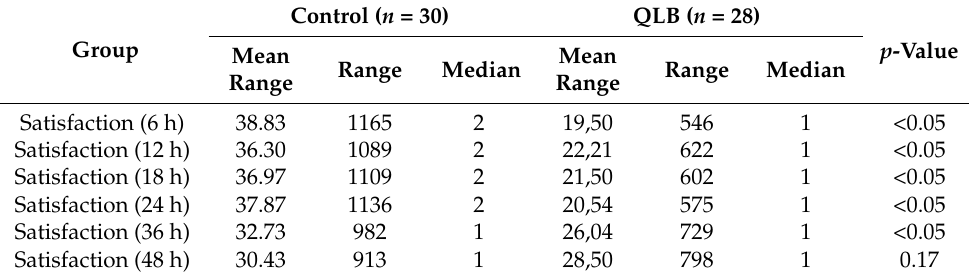
Table 2. Evaluation of satisfaction with pain therapy in 3-point scale. The Shapiro–Wilk test was used to test for normality. A non-parametric Mann–Whitney U test was used when the obtained values did not follow normal distribution. Data are shown as medians, range, and mean range.